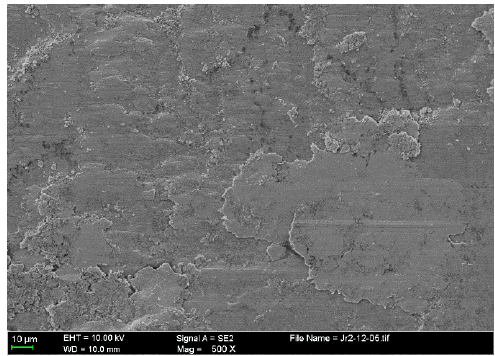
Figure 13. Enlarged worn surface from the CKS ring.